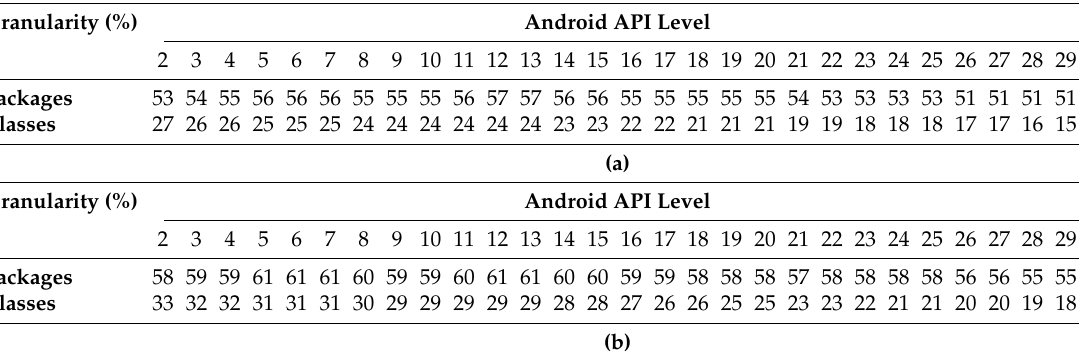
Table 1. Number of available packages and classes for each Android API level. In Table 1a, only constructors without parameters are considered, while in Table 1b, we also include constructors that receive primitive